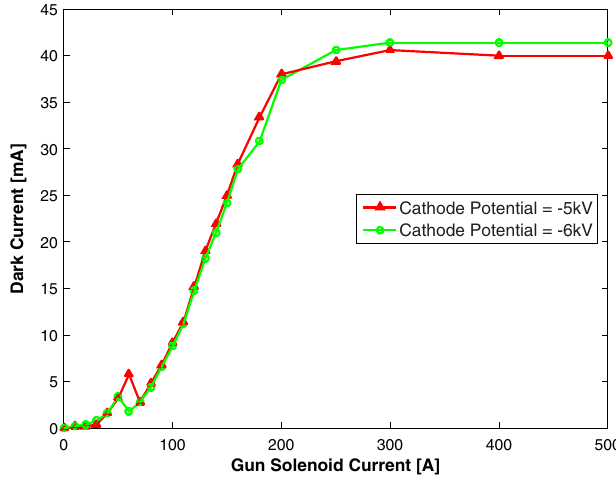
FIG. 11. Electron beam current caused by cathode